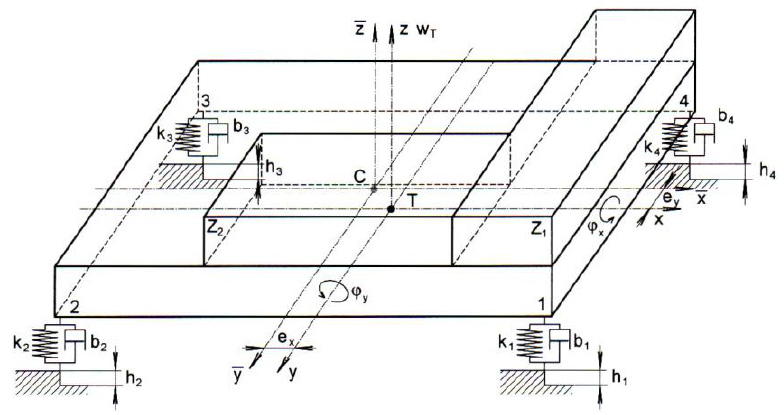
Figure 1. Simple general model of the vehicle.